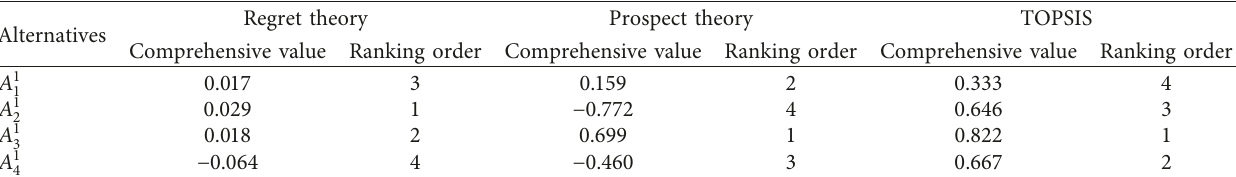
Table 5: Ranking results by using three different decision-making